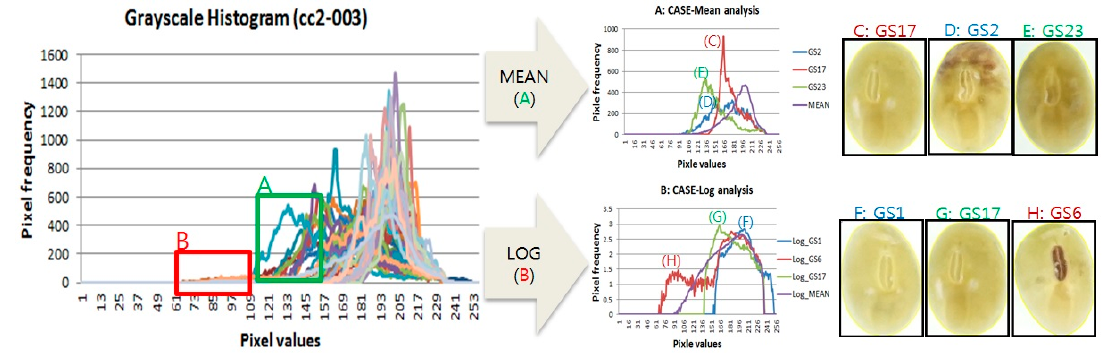
Figure 6. Grayscale graph analysis of cc2-003 line. A green box A shows the results C, D, E using the mean value and a red box B shows the results F, G, H using the mean